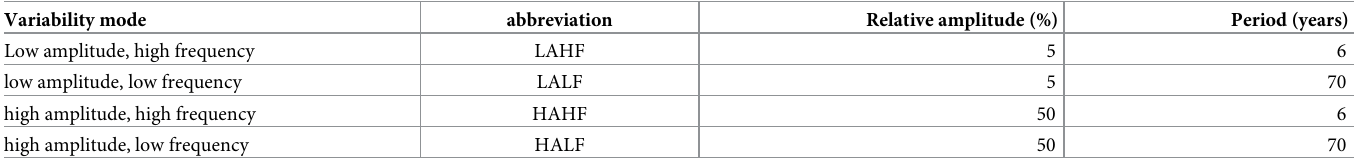
Table 1. The four different modes of variability. They are sine wave functions varying over a base of 1 million kg food resources per year. The amplitude in a mode can either be 5% or 50% and the period of the sine wave can either be 6 years (high frequency) or 70 years (low frequency). Variability